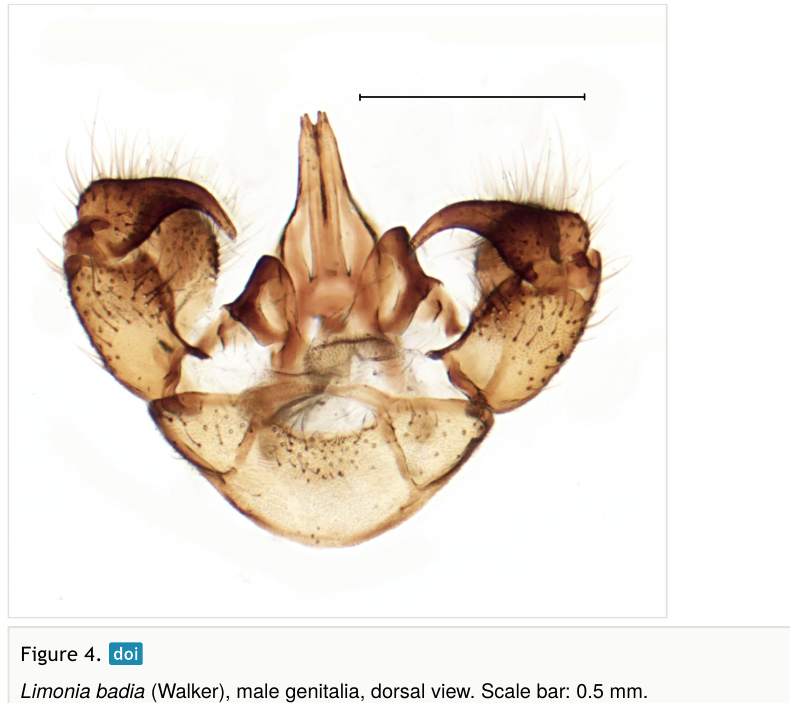
Limonia badia (Walker), male genitalia, dorsal view. Scale bar: 0.5